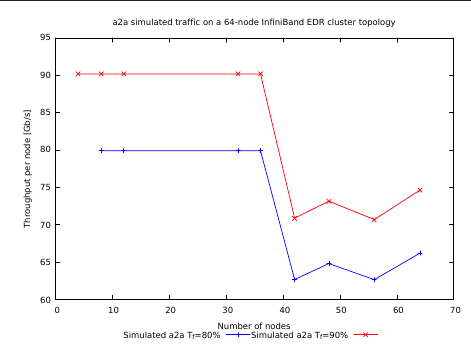
Figure 4. Simulation of the a2a benchmark on a simulated replica of a real HPC 64 nodes cluster. The plot depicts the minimum node throughput vs the number of nodes for target throughput fraction: T f = 80% in blue and T f = 90% in red.